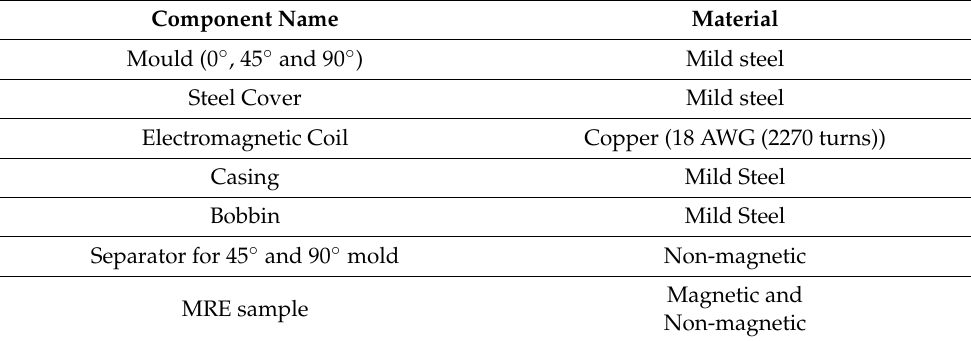
Figure 1. The anisotropic curing device ( a ) design of casing ( b ) design of mold ( c ) schematic diagram. Table 1. Input parameter of the components in the curing device of anisotropic MRE to be run in Finite element method magnetic (FEMM).